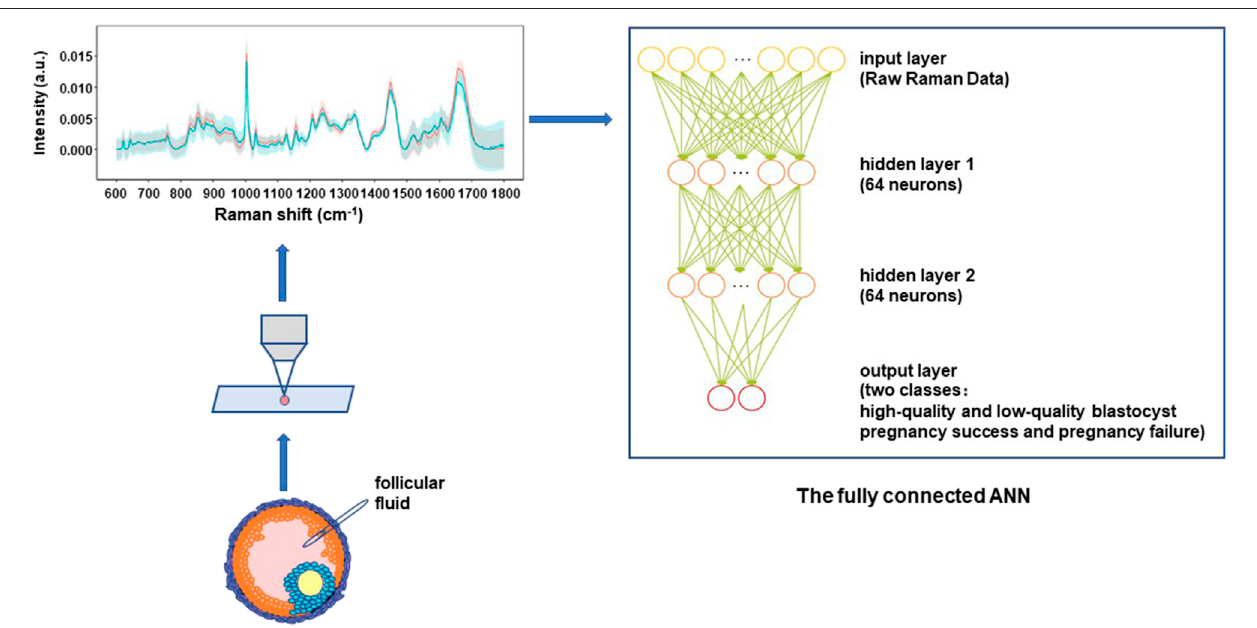
FIGURE1| The schematic architectureofthe fullyconnectedarti fi cial neural network (ANN) forclassi fi cation modelsusing Ramanspectra.Follicular fl uid ofPCOS patient were collected and transferred onto an aluminum slide, and tested using Raman spectroscopy. Two full-connection layers were selected for constructing the ANN modelsinthisstudy.Thestructure oftheANNincluded oneinputlayer,2hiddenlayersthatcontained64neuronsand64neurons,aswellasoneoutputlayer.The algorithm and principle of the ANN model in details can be found in the Materials and Methods section.